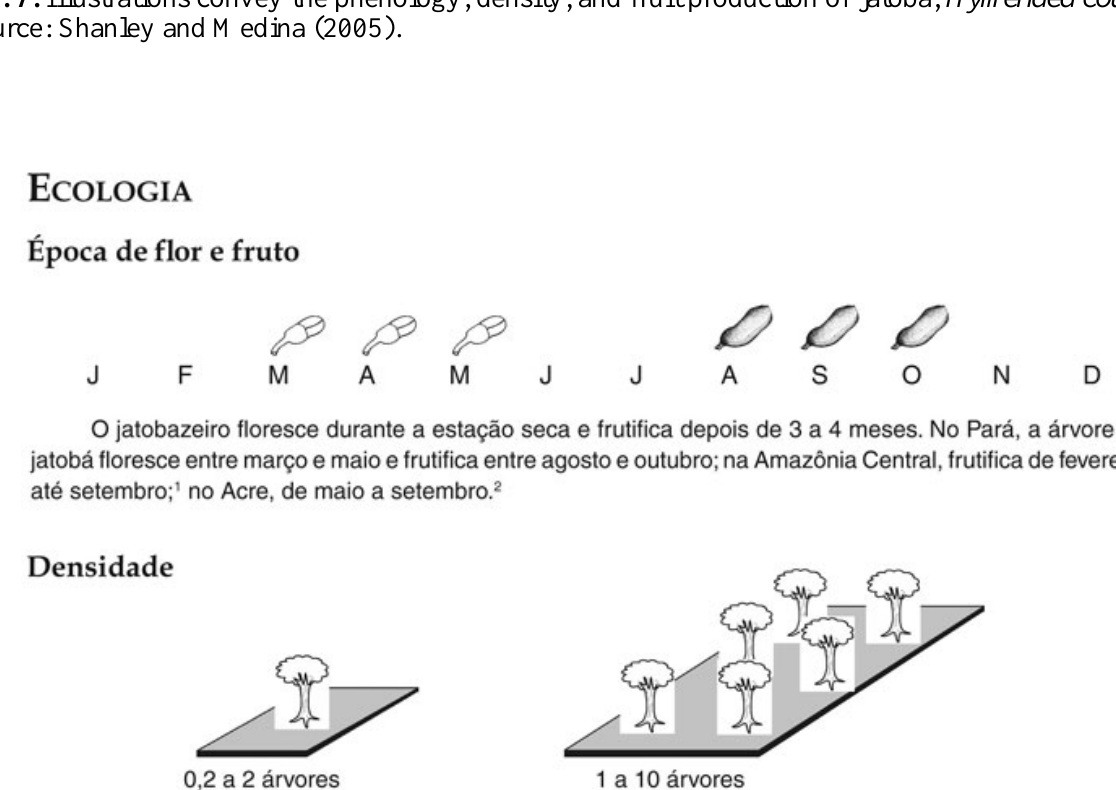
Fig. 7. Illustrations convey the phenology, density, and fruit production of jatoba, Hymenaea courbaril . Source: Shanley and Medina